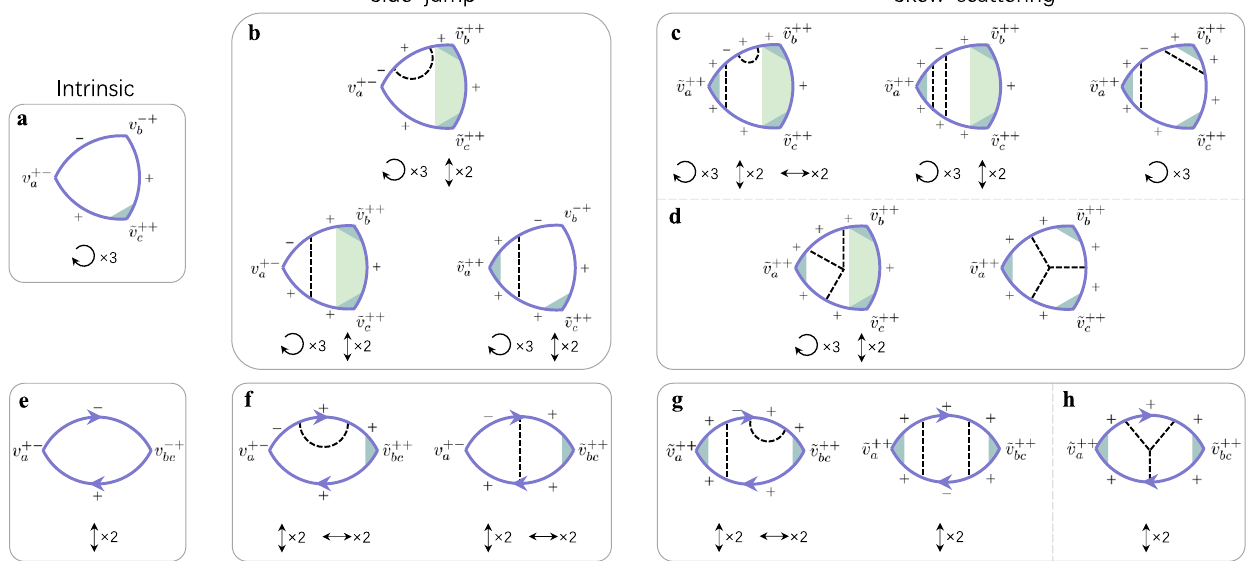
Fig. 1 Feynman diagrams for the nonlinear Hall conductivity. The Eigen bands of a generic two-band model are labeled as ± and the Fermi energy is assumed to cross the + band. a – d are the triangular diagrams and e – h are the two-photon diagrams. These diagrams can be classi fi ed into intrinsic ( a and e ), side-jump ( b and f ), intrinsic skew-scattering ( c and g ), and extrinsic skew-scattering ( d and h ) contributions. The solid lines stand for the Matsubara Green ’ s function of the + or − band. The dashed lines represent the disorder scattering. The gray and green shadows represent the vertex and edge corrections, respectively. The triangular diagrams can be labeled as both clockwise and anticlockwise arrows 48,50,54 – 56 , which we count as one diagram. The symbols ↻ × 3, ↕ × 2, and ↔ × 2 represent the threefold permutation, up-down and left-right reverse of the scattering kernel and accordingly the labels of the Green ’ s functions and vertices. These symbols give the number of each type of diagram. For example, a has three diagrams by threefold permutations of the { − , + , + } labels. All of these diagrams can be found in Supplementary Figs. 5 – 9 (triangular) and 11 – 15